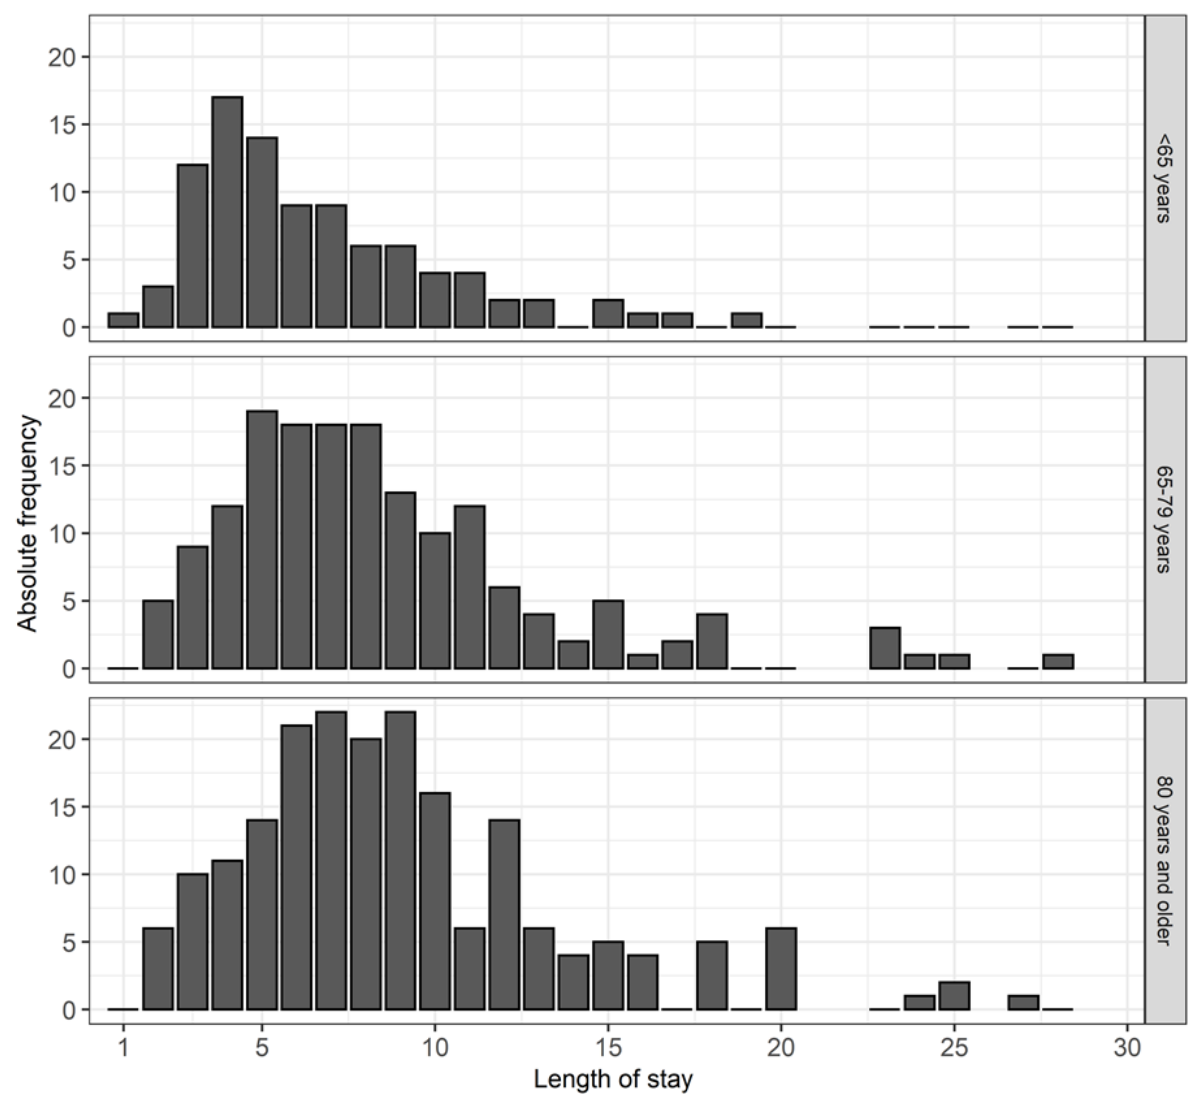
Figure 1. This figure shows the length of hospital stay for each age